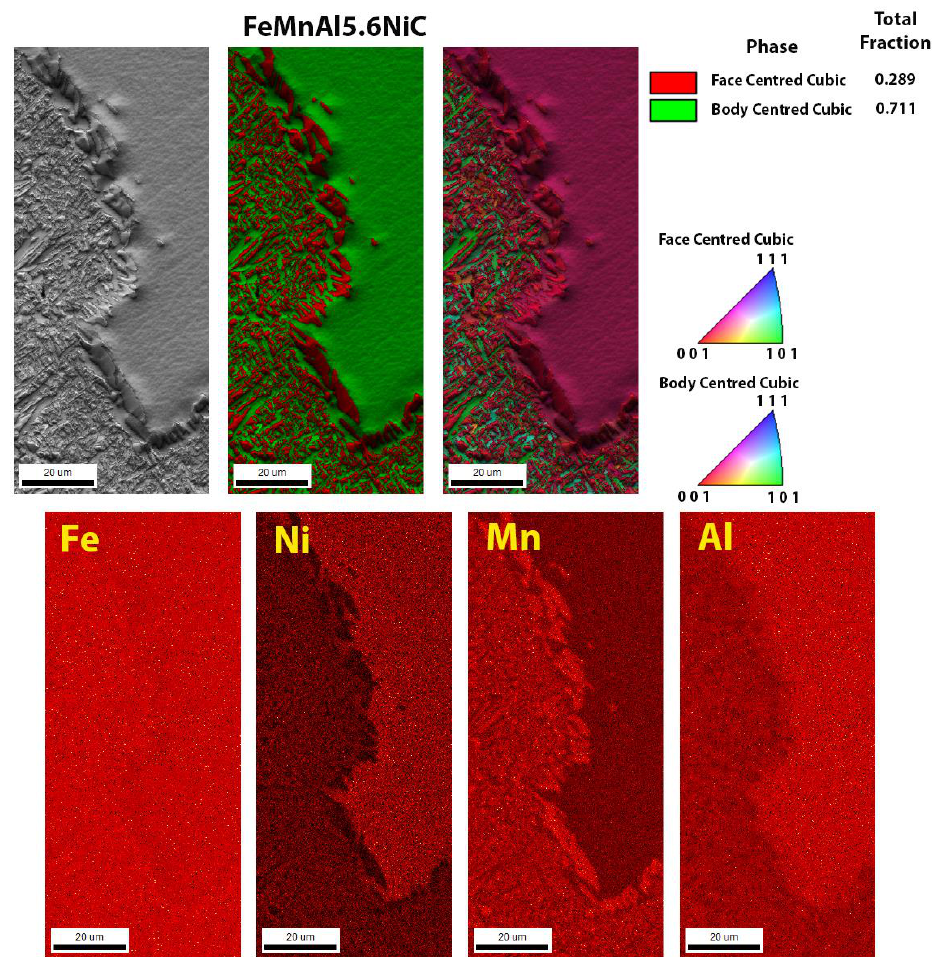
Crystals 2021 , 11 , x FOR PEER REVIEW 11 of 14 Figure 9. Electron backscattered diffraction analysis of a sample as-cast FeMnAl5.6NiC sample and SEM EDS (Energy-dispersive X-ray spectroscopy) elemental mapping of Fe, Ni, Mn, and Al.